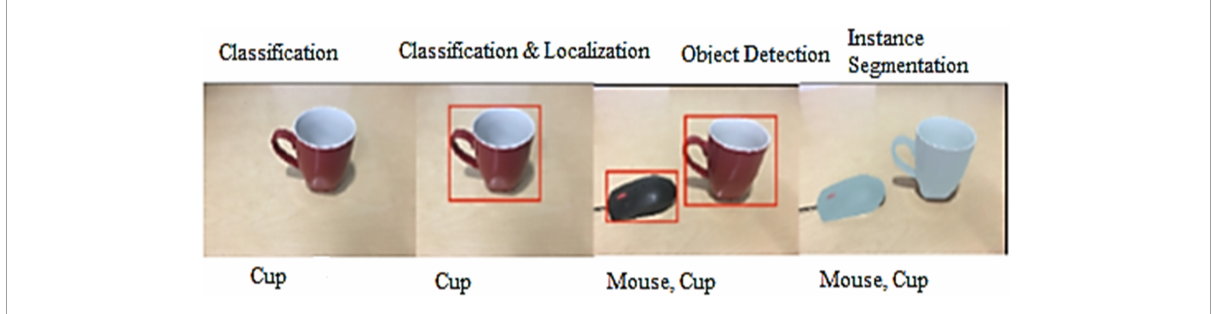
FIGURE3 Classification, localization and instance segmentation.